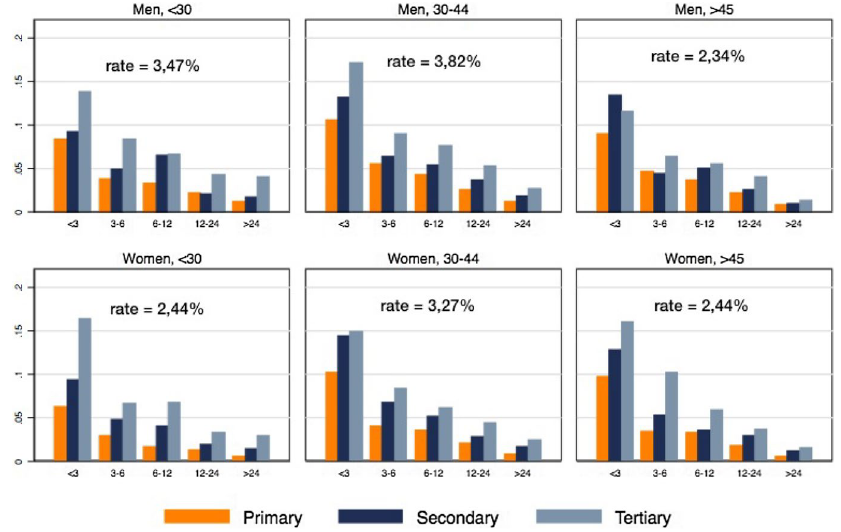
Fig. 3 Exit rates in to the labour market of MIP perceivers in Basque Country, 2015. Axes: gender, age, unemployment duration (months), educational level. Source : Own elaboration. Lanbide microdata